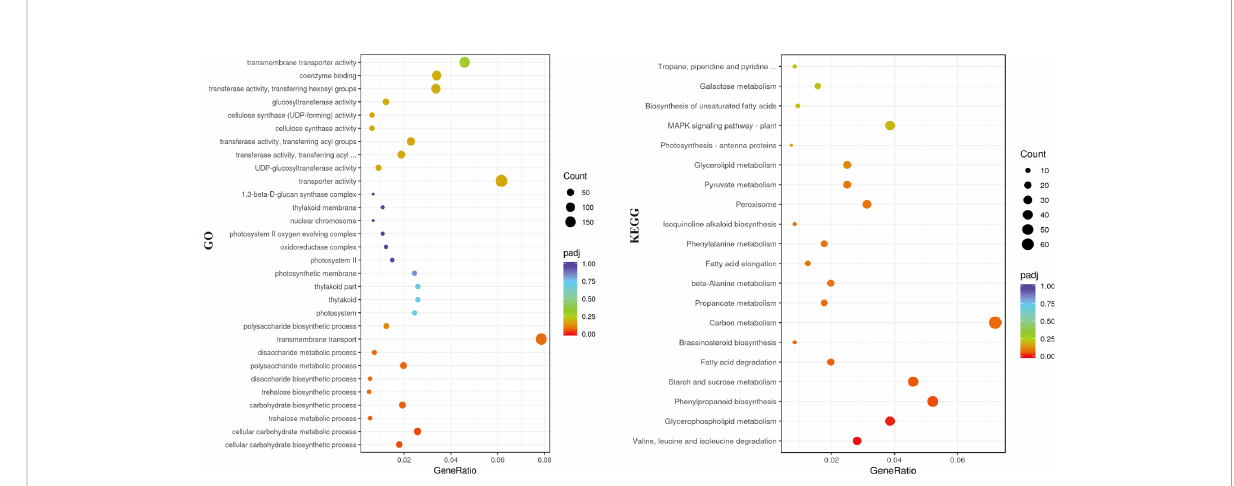
FIGURE 4 Genes enriched in different categories in the GO (left) and KEGG (right) analysis. X-axis represented the gene ratio of enriched genes among the background genes in different categories and y-axis represented the GO or KEGG terms. A high padj-value was represented by red, and a low value represented by purple. The size of the bubble represented number of genes annotated to each term.